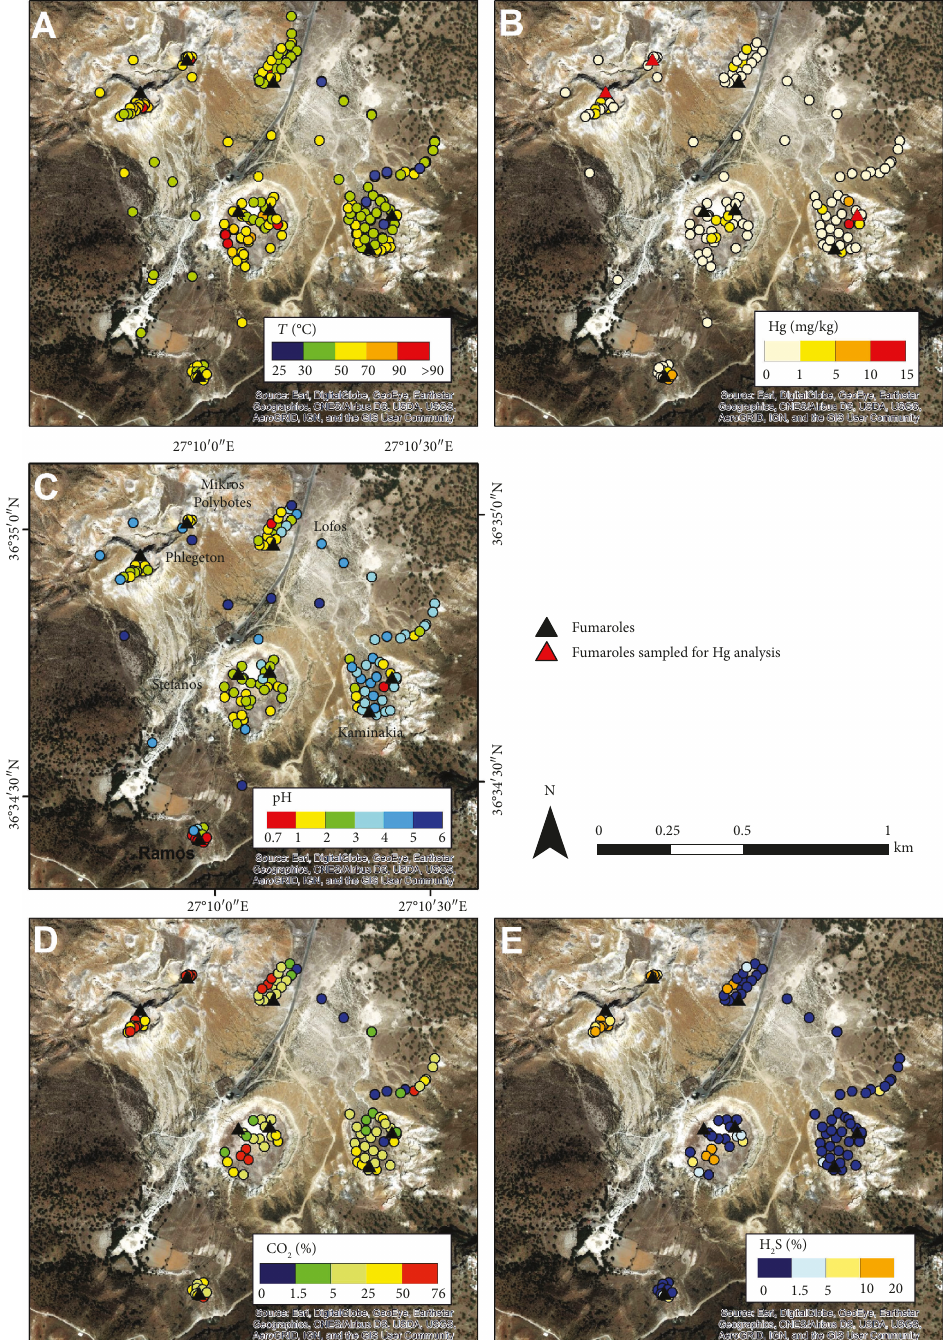
Figure 5: Distribution maps of soil temperature (a), Hg soil concentrations (b), soil pH (c), soil CO Lakki Plain